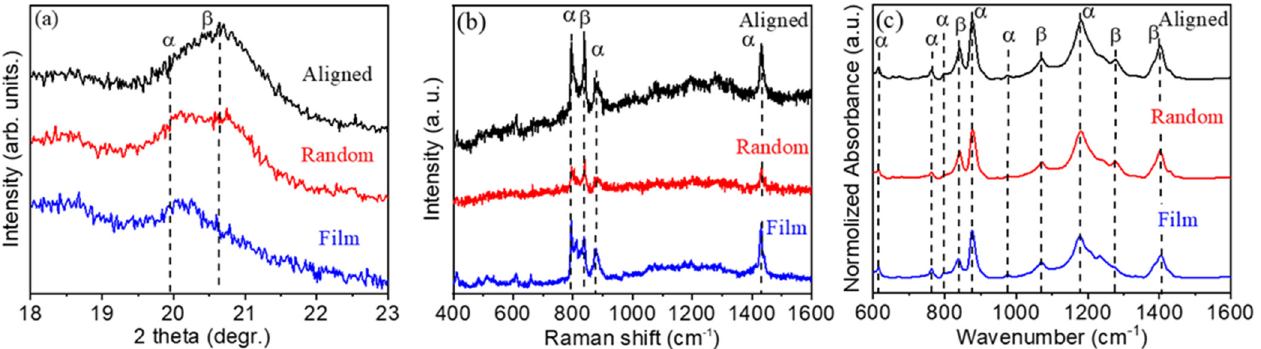
Figure 3. XRD pattern ( a ), Raman spectra ( b ) and FTIR spectra ( c ) of the a-PVDF, r-PVDF nanofibers and f-PVDF film, respectively.